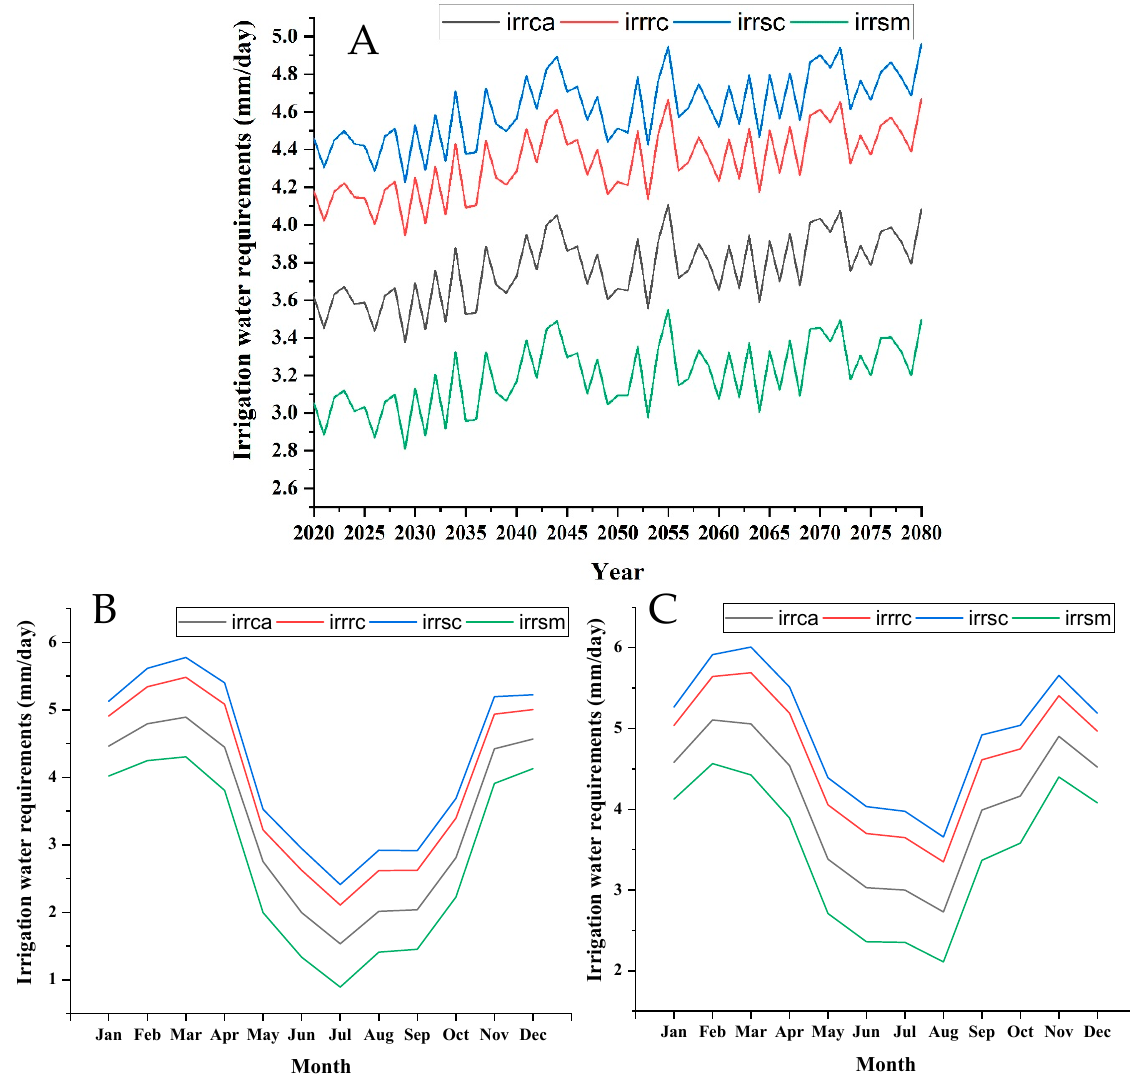
Figure 5. Evolution of IWR (in mm/day) under CSIRO RCP 8.5. ( A ) Demonstrates annual irrigation water requirements. ( B ) Demonstrates monthly irrigation water requirements for 2027, with the lowest irrigation water requirements by crops. ( C ) Demonstrates monthly irrigation water requirements for 2079, with the highest irrigation water requirements by crops. Same as Figure 3.